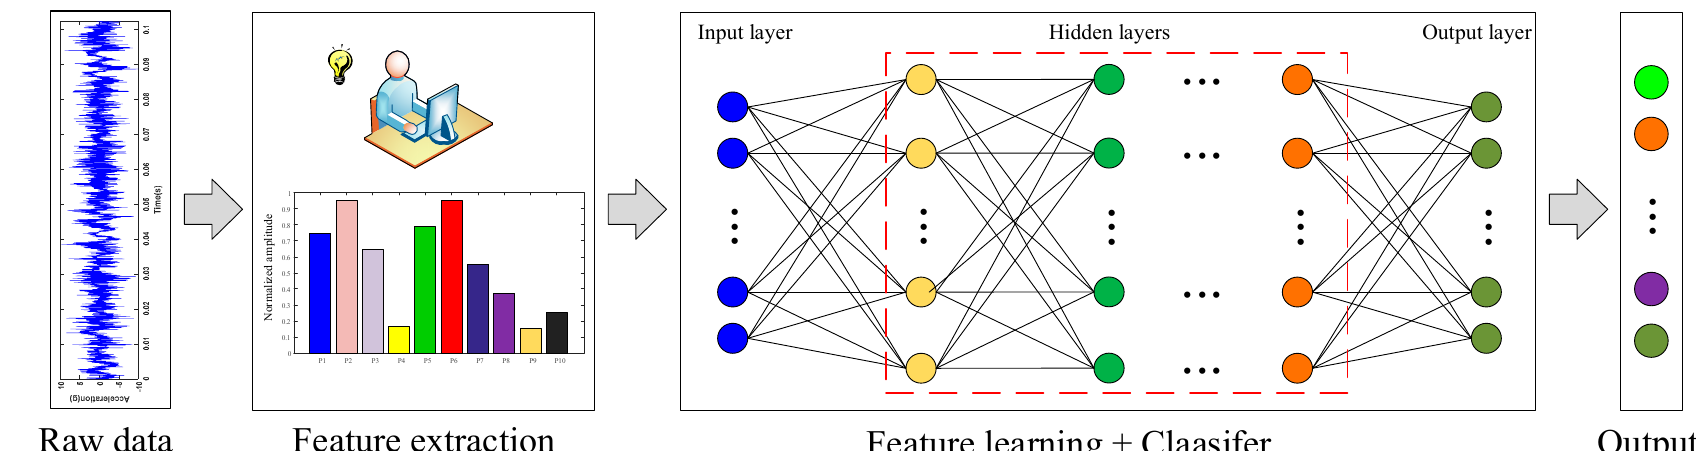
Figure 3. Axle-box bearing fault diagnosis approach based on feature extraction and deep learning.